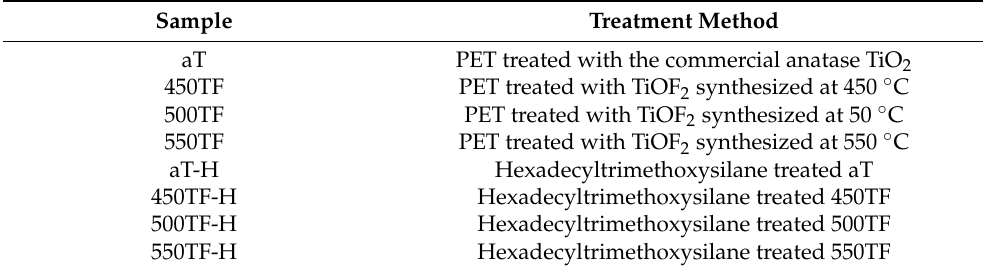
Table 1. Sample labels used in this study based on preparation